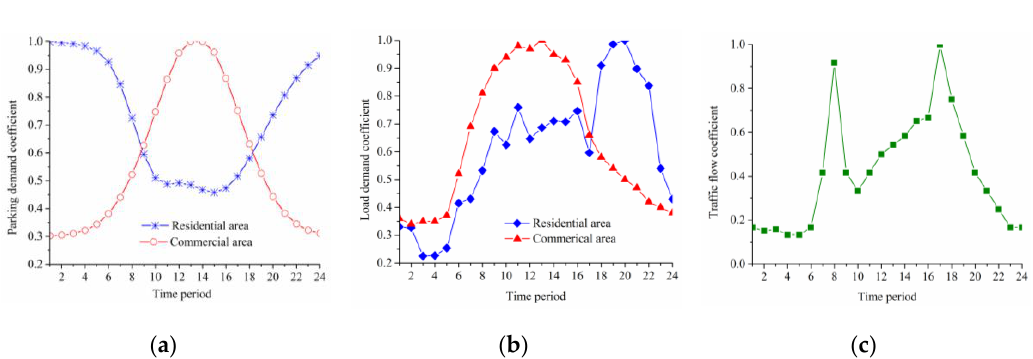
18 Table 2. Unit fixed and variable investment for candidate CS ( ×10 4 USD). Bus